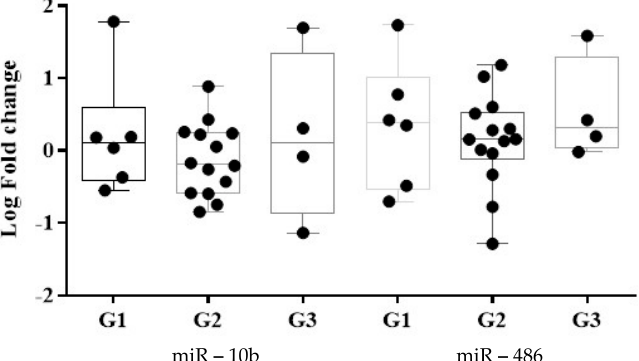
Figure 4. Tumor grading classification using the expression level of miR ‐ 486 ‐ 5p and miR ‐ 10b ‐ 5p. Data were analyzed using Mann ‐ Whitney ‐ Wilcoxon rank sum test and represented as Log of Fold Change. (G1 = well ‐ differentiated; G2 = intermediate ‐ differentiated; G3 = poorly differentiated) ROC curves were built to assess the discriminatory capacity of the two dysregulated miRNAs as possible biomarkers for OOC detection The ROC curves express the sensitivity and specificity for each miRNA, the AUC indicating the discrimination power of the biomarker (Table 3). The miR ‐ 486 ‐ 5p and miR ‐ 10b ‐ 5p exhibited relative AUCs (standard error; 95% confidence interval; p values) of 0.72 (0.07; 0.57, 0.88; 0.01) and 0.59 (0.08; 0.43, 0.76; 0.26) for malignancy identification. The miR ‐ 486 ‐ 5p had a higher AUC in oropharynx cancer detection compared with oral cavity cancer. Furthermore, compared to stages III and IV, the miR ‐ 486 ‐ 5p exhibited a greater cancer detection AUC in stage II and has the highest AUC for G3 and non ‐ keratinized SCC identification. The miR ‐ 10b ‐ 5p had the greatest AUC OOC detection in stage IV of the disease and oral cavity cancer sites. The G2 and non ‐ keratinized SCC presented a higher AUC compared with the other histopathological type of the OOC. Table 3. Area under the curve of oral and oropharyngeal cancer detection using miR ‐ 486 ‐ 5p and miR ‐ 10b ‐ 50.